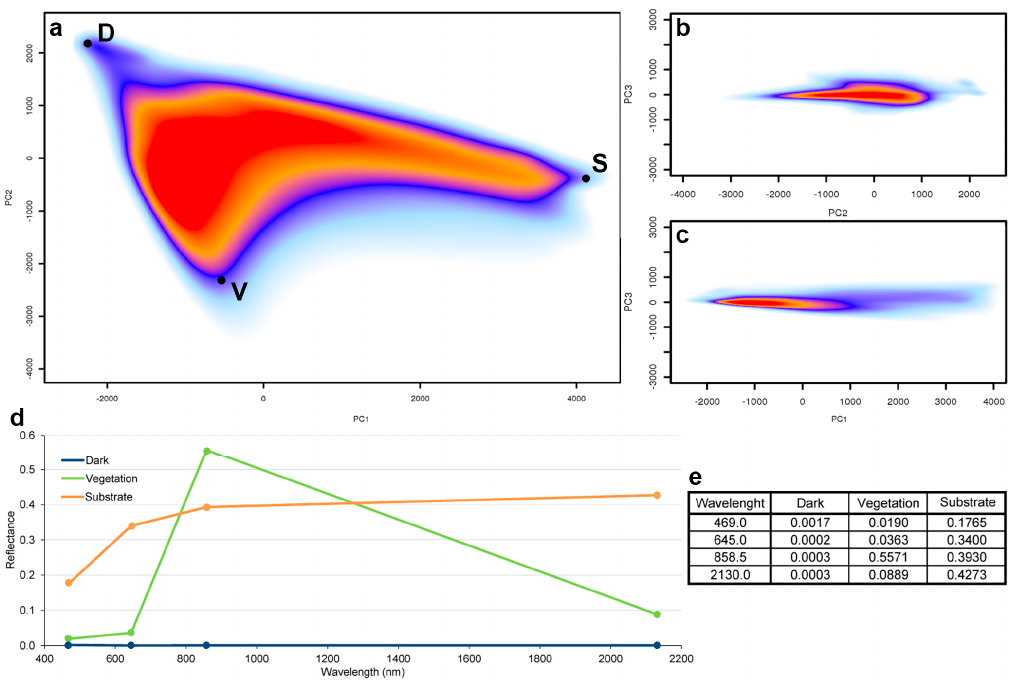
Figure 2. Global composite spectral mixing space and spectral endmembers. Scatterplots displayed with density colors are the orthogonal projections of three primary principal components (PCs) computed from global MOD13A3 data (monthly, at 1-km spatial resolution) acquired during 2001. ( a ) Global composite spectral mixing space of the first and second principal components. Black dots indicate substrate (S), vegetation (V) and dark surface (D) global spectral endmember positions. ( b ) Global composite spectral mixing space of the second and third principal components. ( c ) Global composite spectral mixing space of the first and third principal components. (d) Spectra of global endmembers. ( e ) Reflectance values of global spectral endmembers. The gap-filling procedure was able to reconstruct a consistent number of missing values to allow the use of complete FCover time series, mostly at lower latitudes. Looking at differences between the percentage of missing